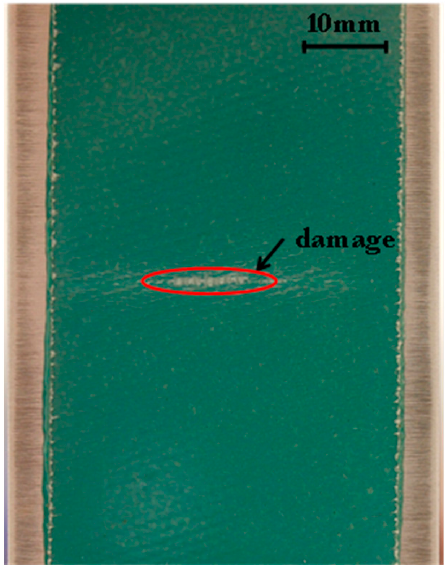
Figure 4. Photograph of the patched face of the repaired coupon after 106,000 fatigue cycles.